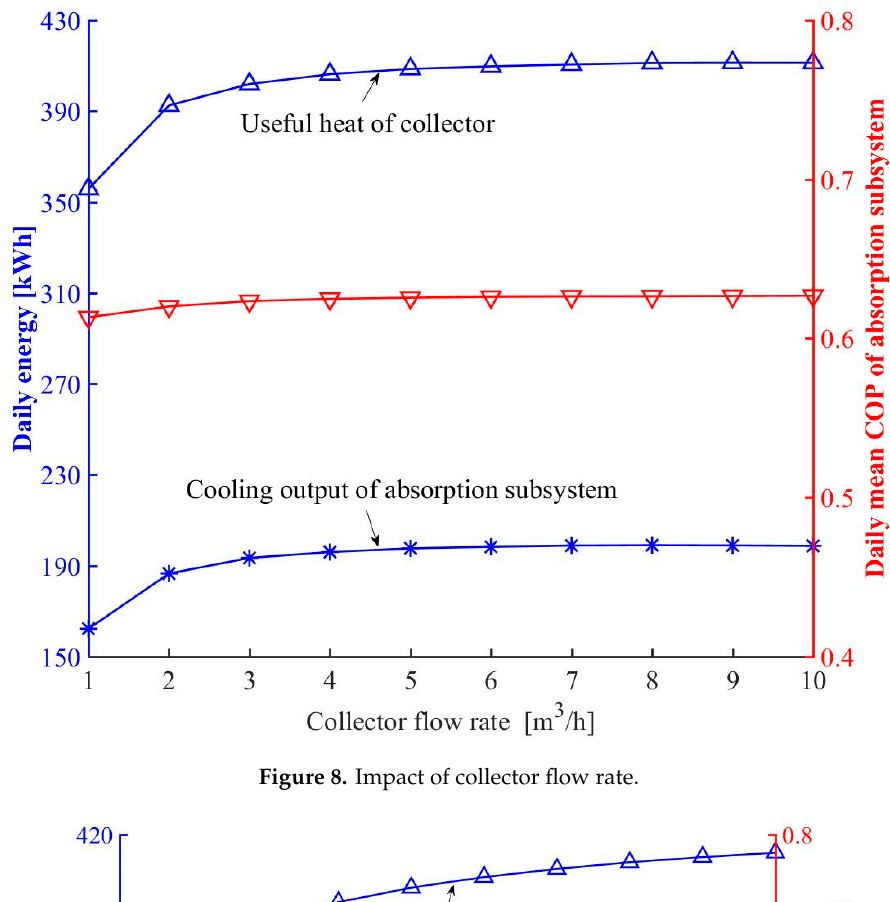
Figure 8. Impact of collector flow rate.